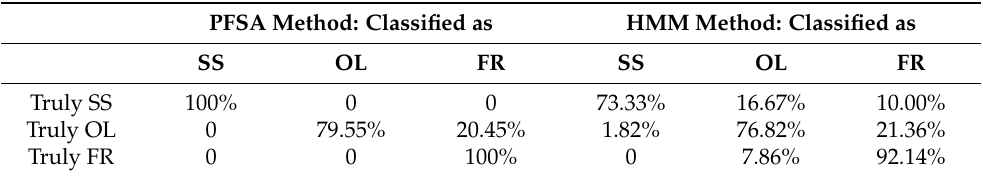
Table 2. Confusion matrix showing the average (over 20 trials) classification accuracy of the time- series regime from the dataset with no radiation heat loss.